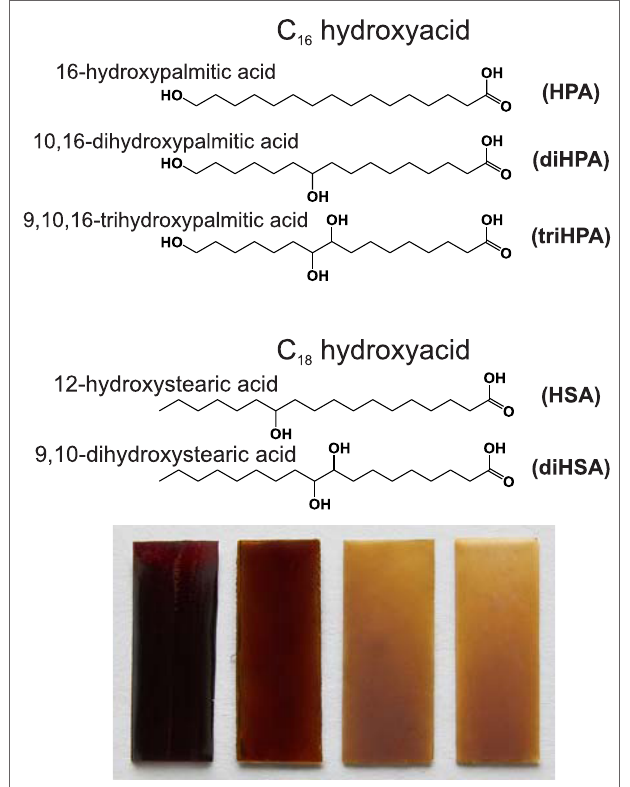
FigUre 1 | chemical structure of monomers, nomenclature used and polyester appearance